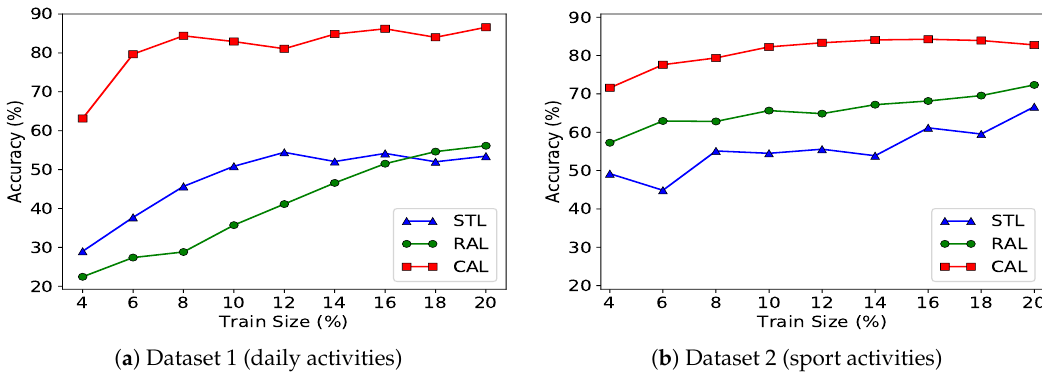
Figure 4. Comparison between the collaborative active learning algorithm (CAL) and two baseline algorithms: an algorithm that randomly selects samples in active learning (RAL) and a simple transfer learning-based approach (STL). The scenario is context change. Subfigure ( a ) shows results for the daily activities dataset, and subfigure ( b ) shows results for the sport activities